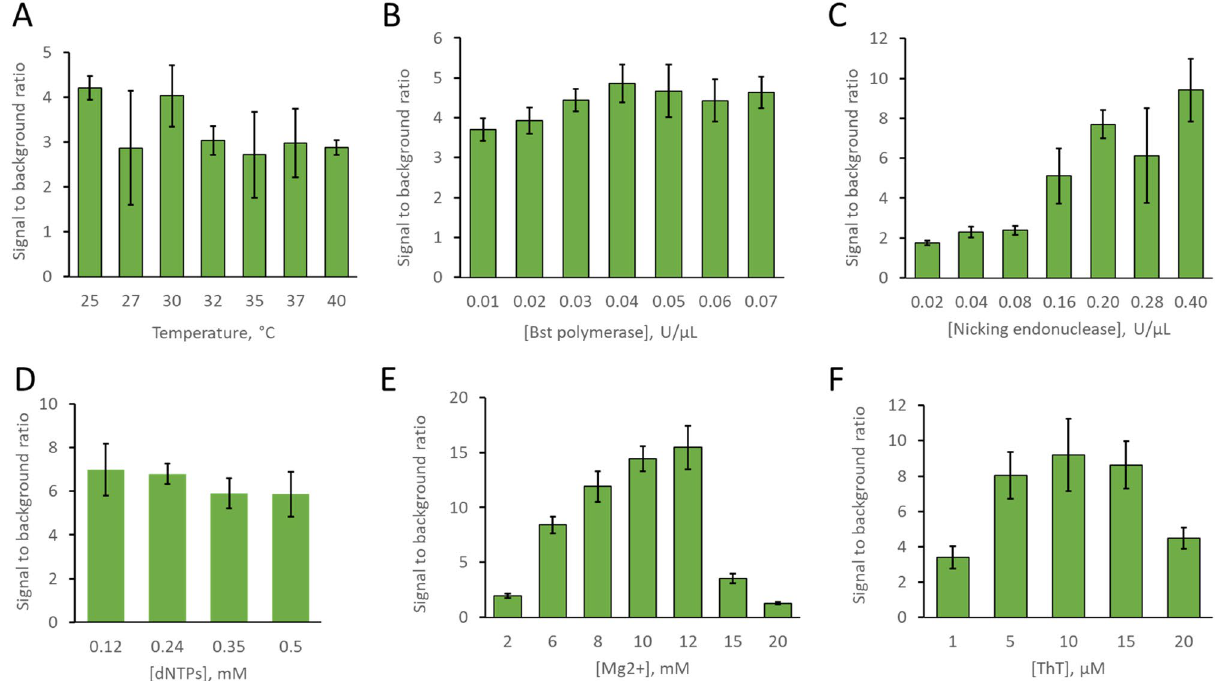
Figure 5. Optimization of six experimental parameters of the strand displacement amplification (SDA). Signal to background ratio (SBR) as a function of ( A ) Temperature, ( B ) Bst polymerase concentration, ( C ) Nicking endonuclease concentration, ( D ) dNTPs concentration, ( E ) Magnesium concentration, and ( F ) ThT concentration. Error bars represent the standard deviation of triplicate measurements in all